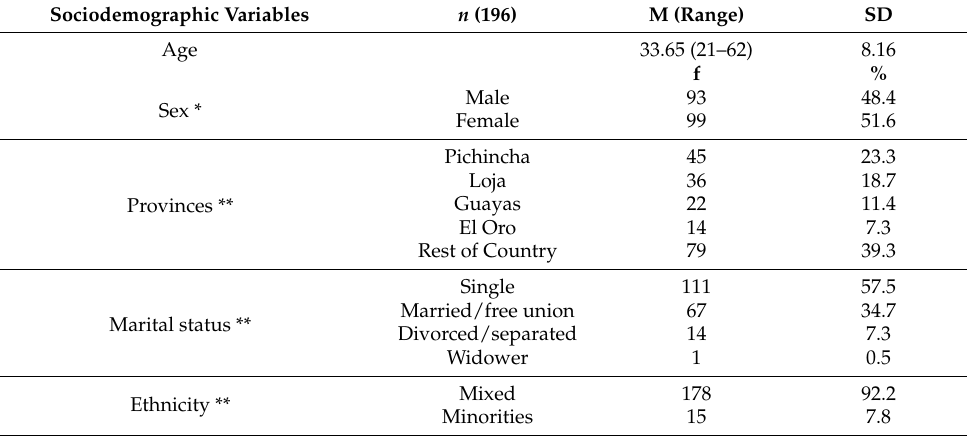
Table 1. Sociodemographic